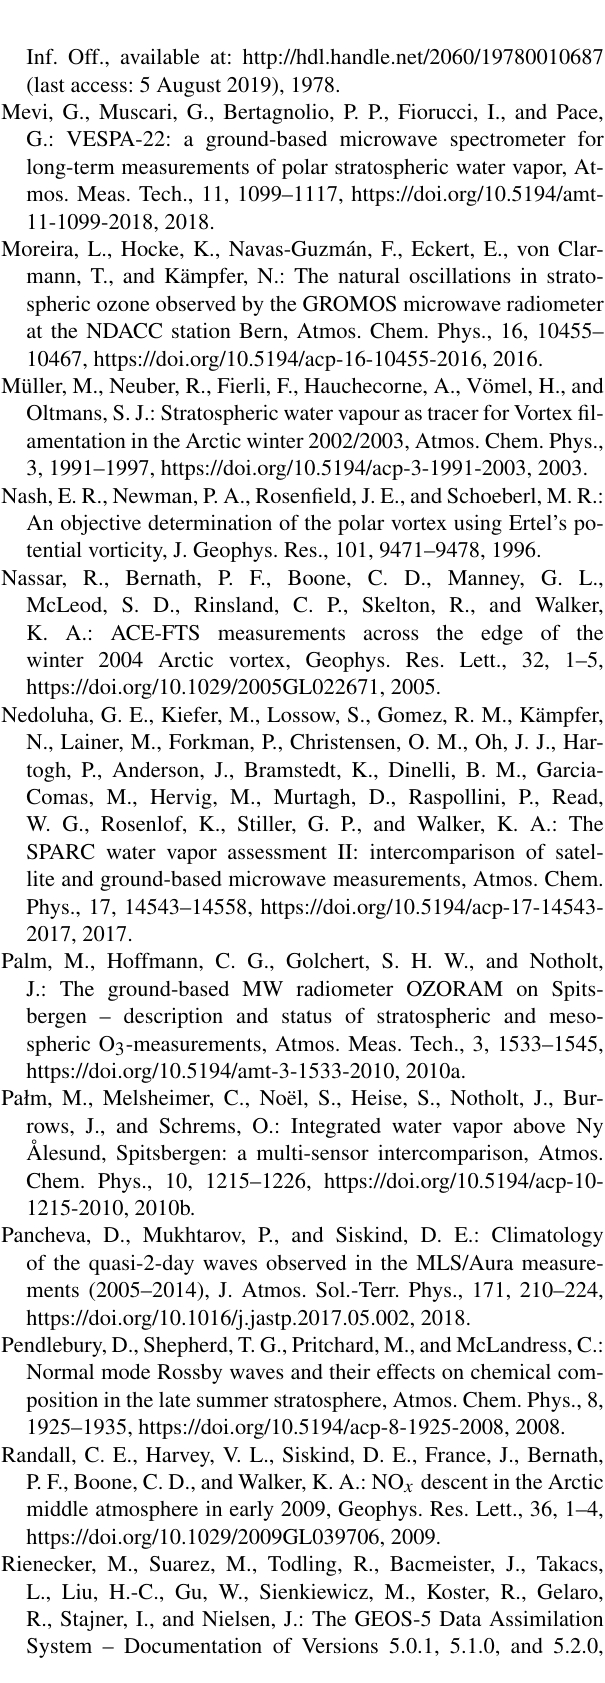
figurations. Part II: Equinox and solstice condition, Am.